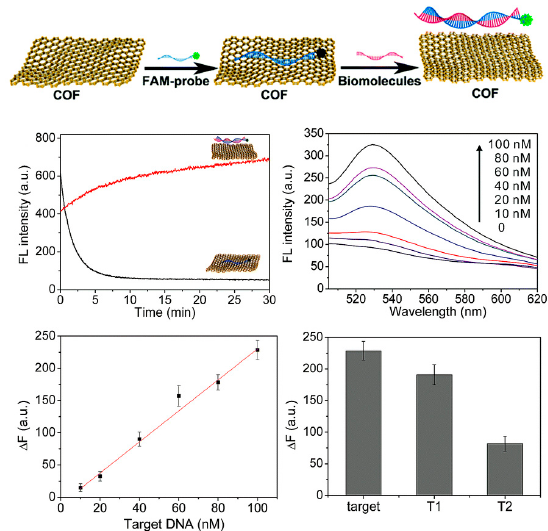
Figure 15. Schematic representations of COF-based sensing platform for DNA detection. Reproduced with permission from [332]. Copyright Royal Society of Chemistry, 2017. with permission from [332]. Copyright Royal Society of Chemistry,